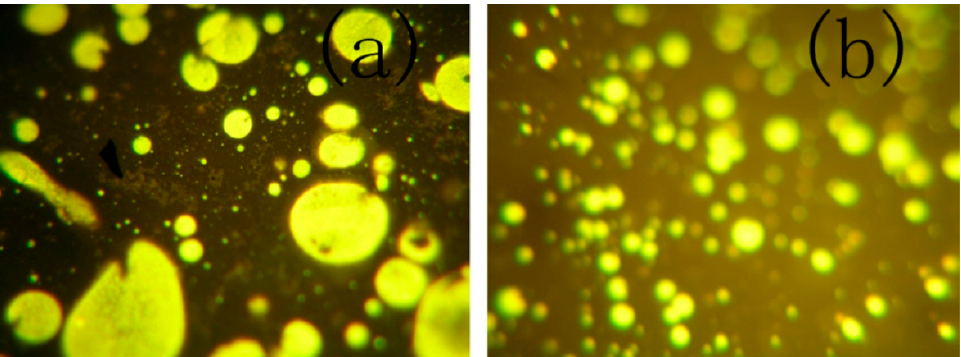
Figure 8. Fluorescence microscopy images showing the morphology of: ( a ) the LDPE and ( b ) GMA-g-LDPE blends (reprinted from [148] with permission of Elsevier).